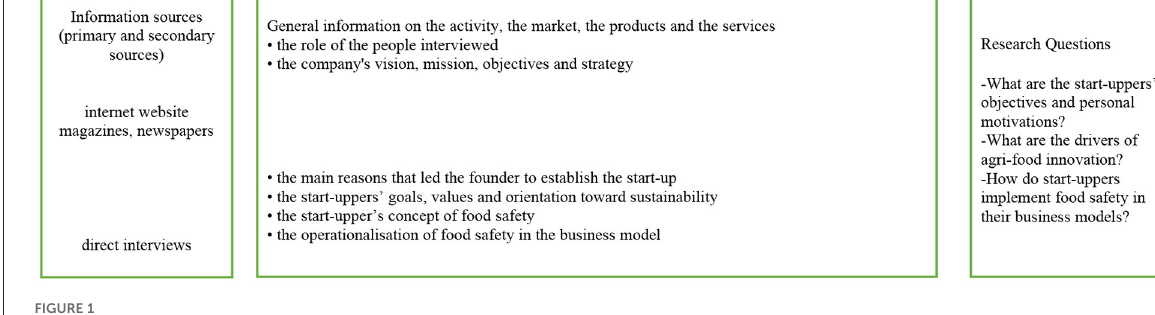
FIGURE1 The research design. Source: author’s elaboration.